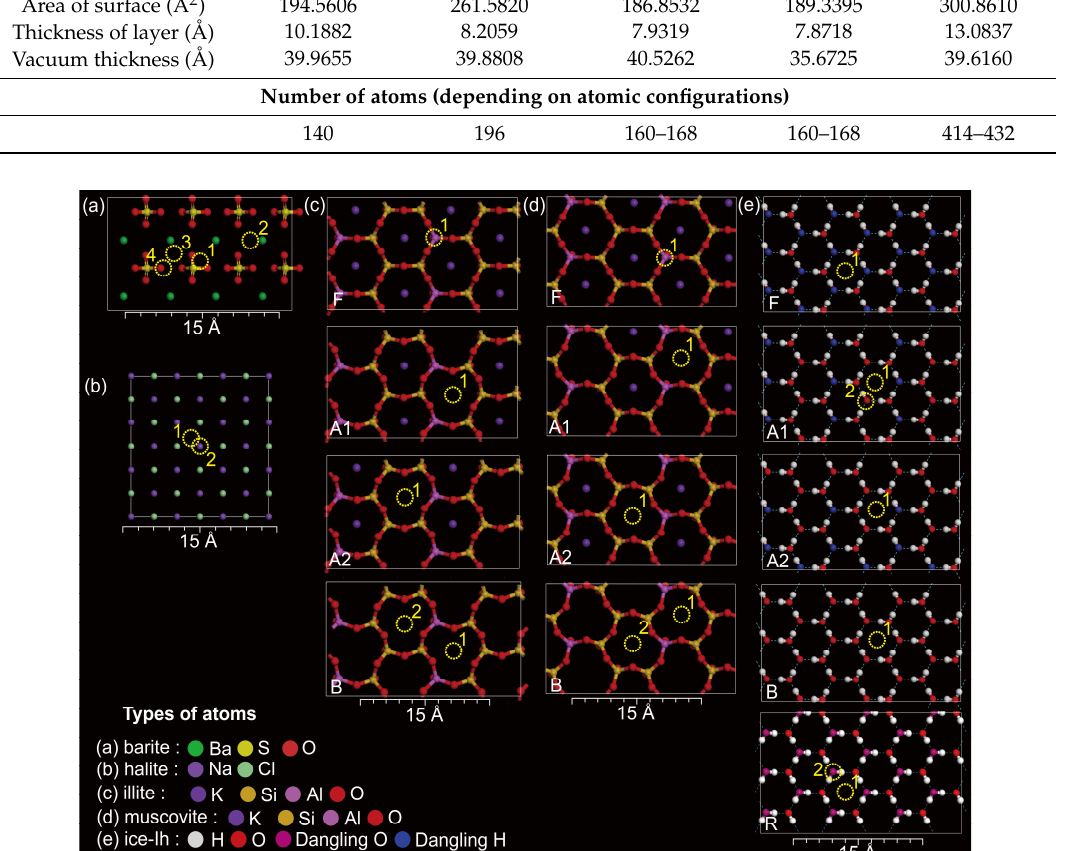
Figure 2. Cleaved surface structures of ( a ) barite, ( b ) halite, ( c ) illite, ( d ) muscovite, and ( e ) ice-Ih viewed perpendicular to the cleavage planes. The barite, halite, illite, and muscovite structures were cleaved in the direction of (001), and the ice-Ih structure was cleaved in the directions of (0001) and (000 1(cid:3364) ). Different occupations of the uppermost K atoms were considered for the surface structures of illite and muscovite: (F) fully occupied, (A1 and A2) partially unoccupied, and (B) fully unoccupied. The surface structures of ice-Ih included various defect structures: (F) the (0001) cleavage plane fully decorated with dangling H atoms, (A1 and A2) the (0001) cleavage plane decorated with proton defects (i.e., partially unoccupied dangling H sites), (B) the (0001) cleavage plane fully decorated with proton defects, and (R) the (0001 ) cleavage plane fully decorated with dangling O atoms. Only the atoms in the uppermost layers are shown. The yellow dashed circles indicate the potential adsorption sites on the cleavage